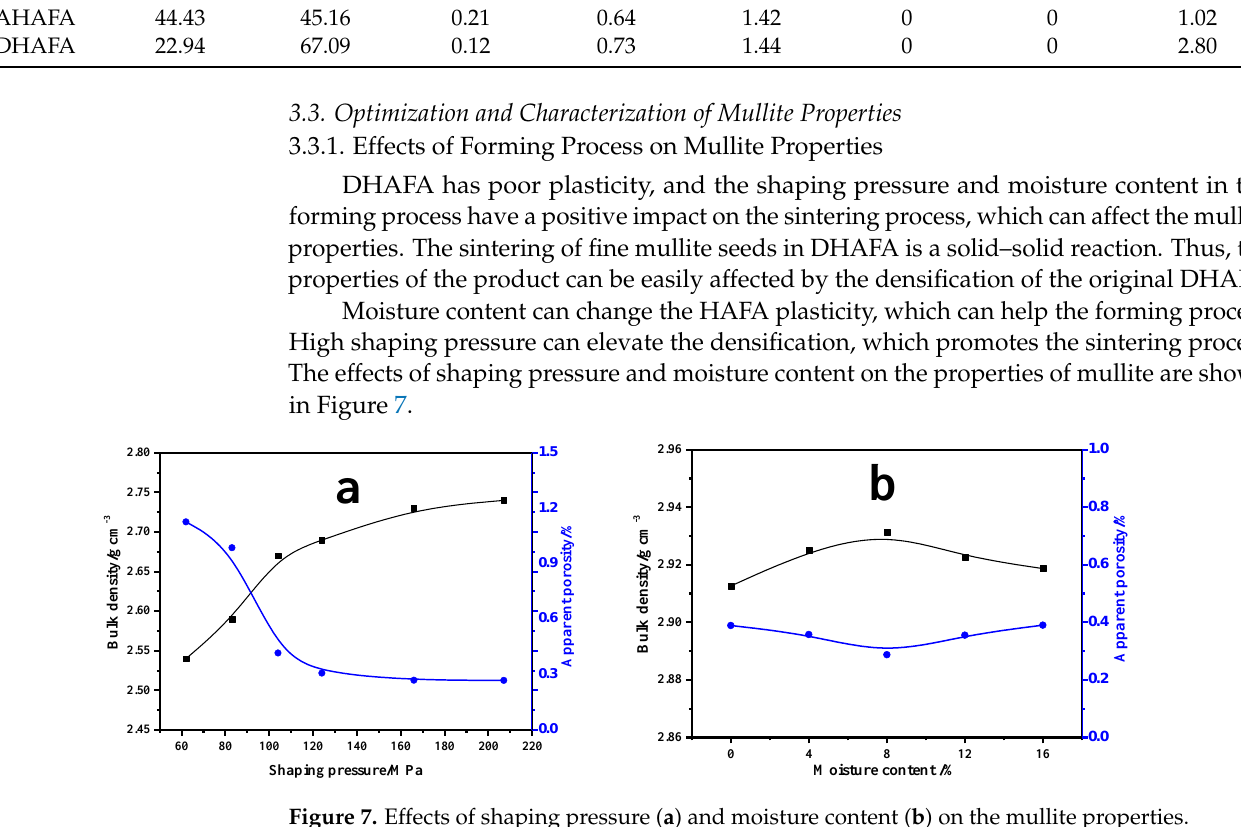
Figure 7. Effects of shaping pressure ( a ) and moisture content ( b ) on the mullite properties.